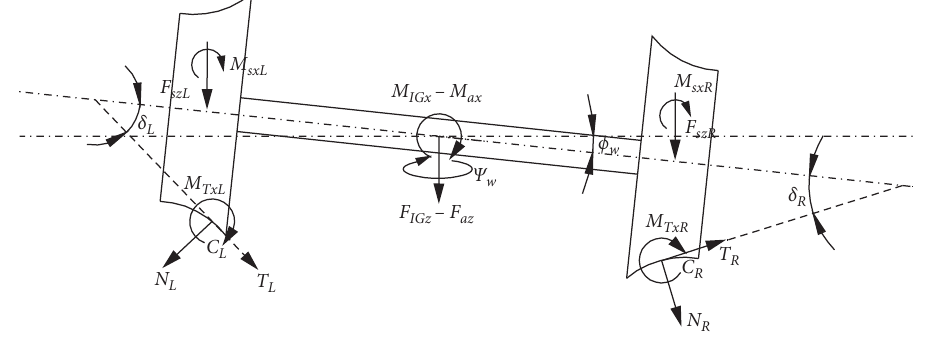
Figure 19: Force decomposition of wheelset.